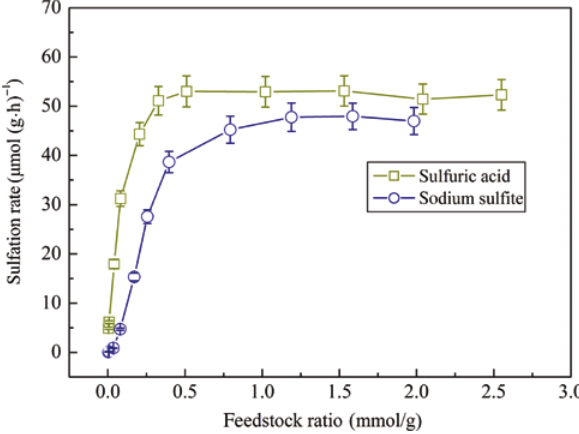
Figure 2: Sulfation reaction kinetics of SVR with sulfuric acid and sodium sulfite, respectively, at different feedstock ratios. The amount of anhydrous ferric chloride used was 1.0%, and tempera- tures for wet curing were 180 ° C and 70 °